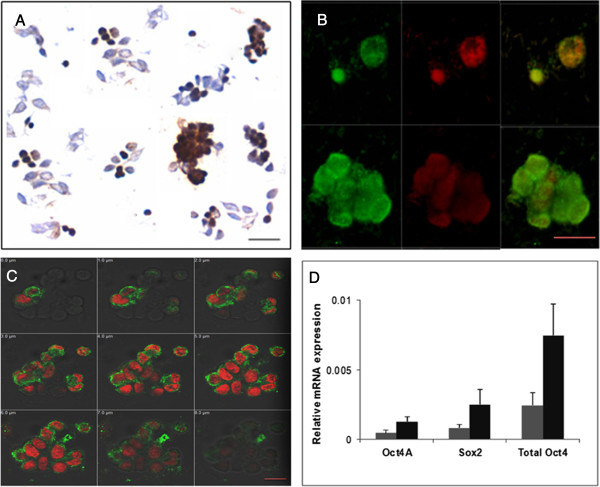
Characterization of stem cells in sheep OSE smears. (A) OCT-4 immunolocalization in OSE smear after 15 hrs of culture with FSH. Note that only stem cells express OCT-4 whereas the somatic epithelial cells are devoid of OCT-4. Scale bar represents 20 μm (B) Confocal imaging of ovarian stem cells stained for OCT-4 with PI as the nuclear counterstain. VSELs express nuclear OCT-4 whereas the slightly bigger OGSCs and also the ‘cysts’ express cytoplasmic OCT-4. First column shows OCT-4 staining, middle panel shows PI staining whereas the third column is the merged image. (C) Confocal image of a cell surface marker SSEA-4 to show cytoplasmic continuity in a germ cell nest or a ‘cyst’. Z stack imaging of a cell cluster collected after FSH treatment shows cytoplasmic continuity between cells due to incomplete cytokinesis and is a distinct feature of clonal expansion of a stem cell. Magnification 63X with 3X zoom (D) qRT-PCR results showing increased relative mRNA expression of pluripotent VSELs specific (Oct-4A and Sox-2) and OGSCs specific (Oct-4) transcripts after 15 hrs of FSH treatment (black bars) compared to without FSH (grey bars). Results are representative of three different experiments.